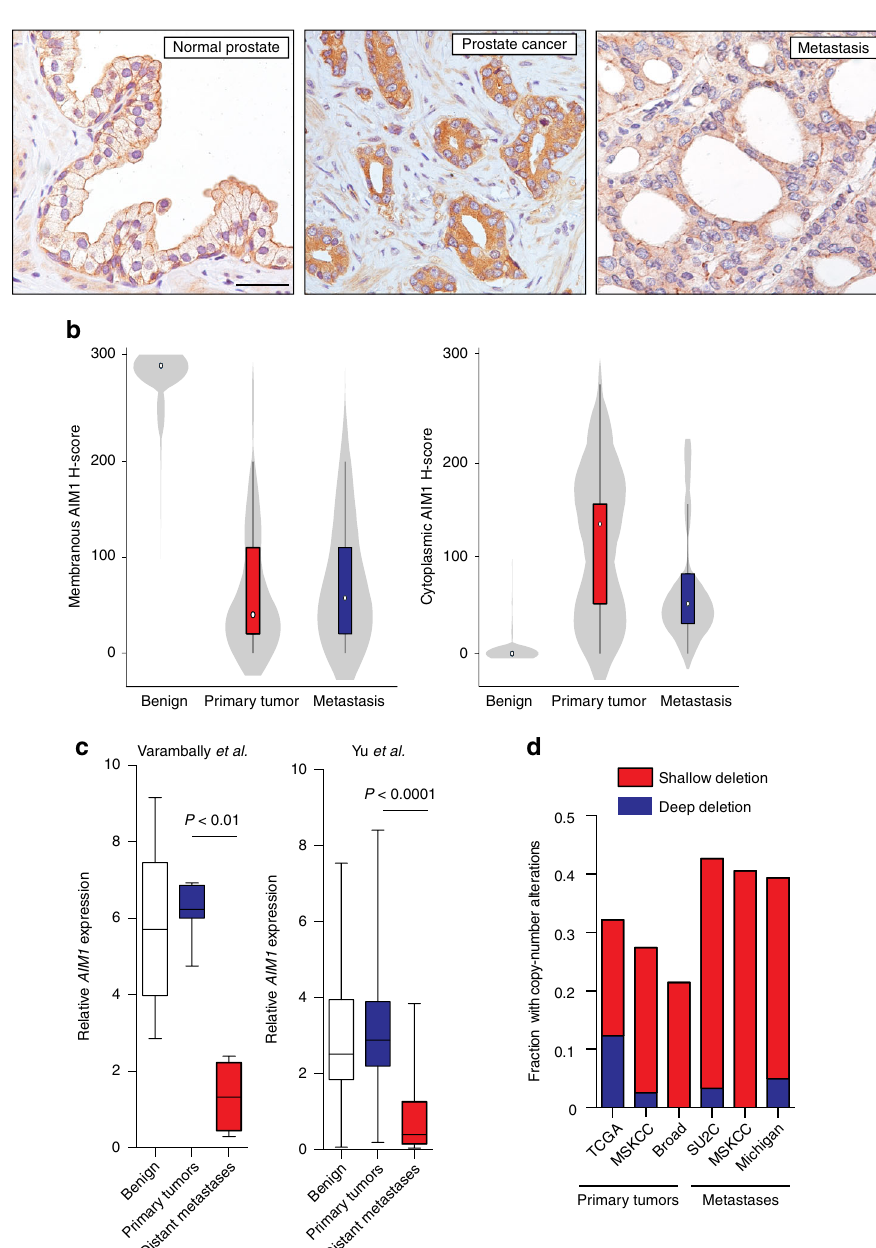
Fig. 8 AIM1 mislocalization and reduced expression is associated with clinicopathologic features of prostate cancer. a Immunohistochemical analysis of 81 normal, 87 primary tumors, and 52 lymph-node metastases stained with AIM1-speci fi c antibodies. Staining intensities and distributions were scored separately for membranous and cytoplasmic staining patterns using the H-score system. Representative micrographs of AIM1 immunohistochemistry in normal prostate, primary prostate cancer, and prostate metastasis are shown. Note the predominant membranous staining pattern in the normal prostate epithelium in contrast to the diffuse cytoplasmic staining in primary tumor and metastatic lesions. The metastasis also showed overall reduced AIM1 expression compared to primary cancer. Scale bars indicate 100 μ m. b Violin plots show H-score distribution for membranous and cytoplasmic immunostaining in normal prostatic epithelium, primary tumors, and metastases. c AIM1 mRNA expression analysis in two independent cohorts reveals profound AIM1 downregulation in distant prostate cancer metastases 38,39 . d Frequency of copy-number loss of the AIM1 gene locus from fi ve